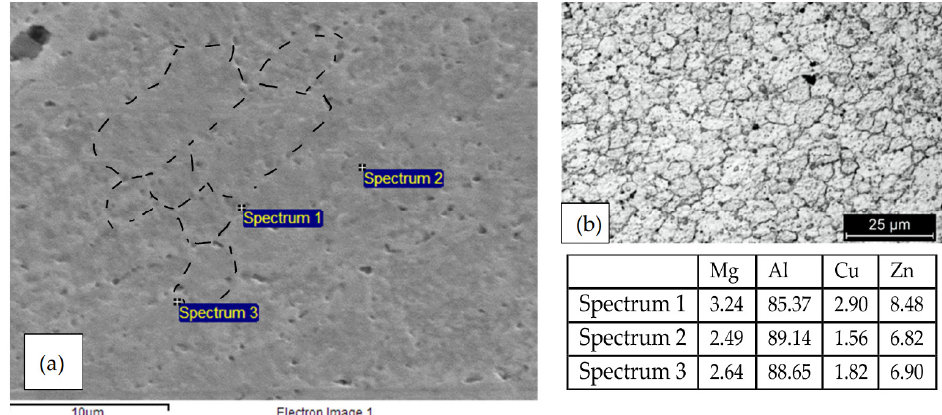
Figure 5. ( a ) SEM image of the nugget of the FWS 7075 alloy (no metallographic attack) the rounded recrystallized grains are visible owing to the precipitates of MgZn 2 on their grain borders and EDX spectra in which is visible an enrichment of zinc and copper in the correspondence of the precipitates. In the image the grain border is demonstrated; ( b ) optical image of the nugget with metallographic attack (Keller’s reagent) that better demonstrated the rounded recrystallized grains.